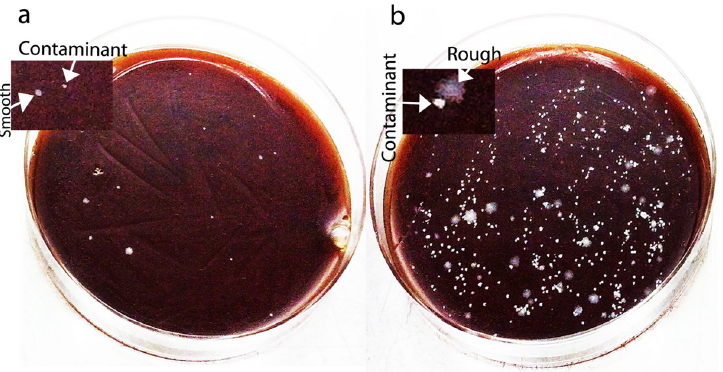
Fig 2. Confirmation of the gastric origin of M . abscessus by 3 wash assay. (a) The BHI blood agar plate that was inoculated with the biopsy without washing with PBS has fewer M . abscessus colonies. (b) The BHI blood agar plate that was inoculated with the biopsy that was washed in PBS 3 times and was homogenized before plating has numerous M . abscessus colonies.